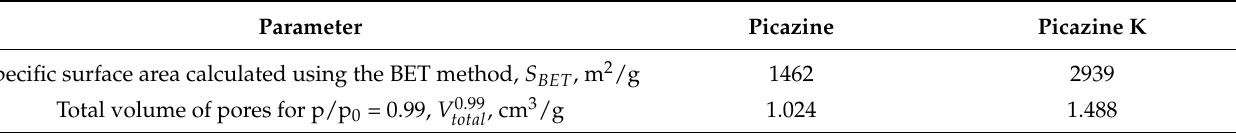
Table 2. Structural parameters of active